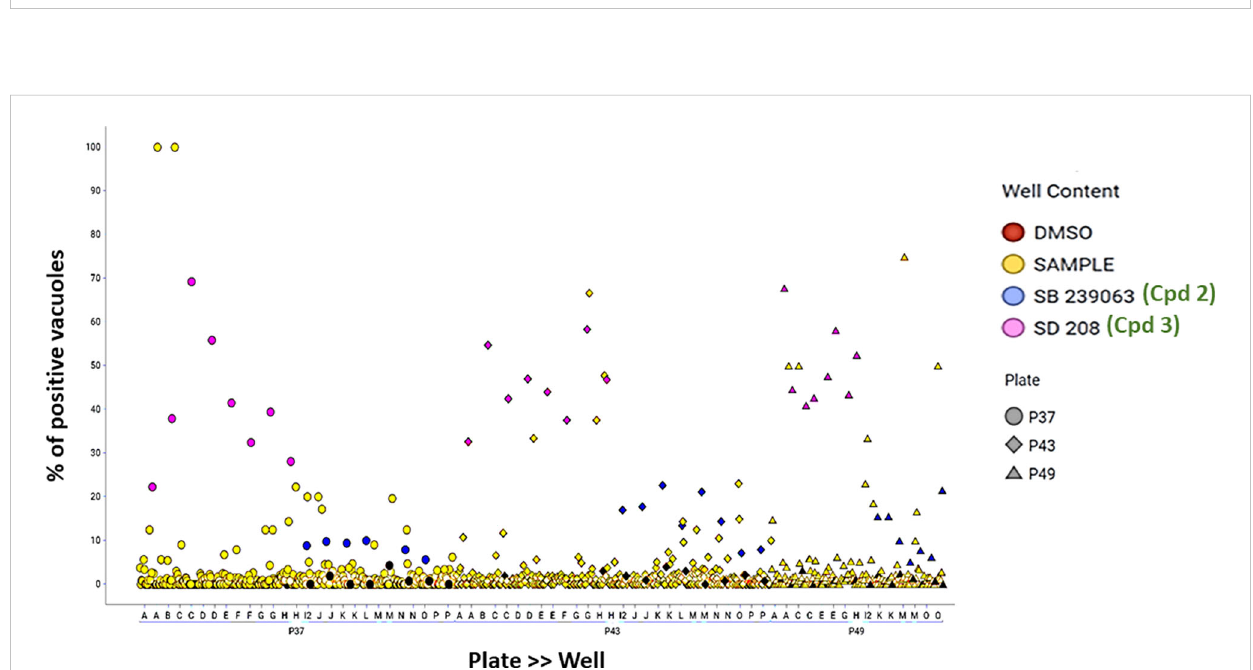
FIGURE 6 Data dot plot for each of the three screening plates — P37 (circles), P43 (diamonds) and P49 (triangles). The percentage of positive vacuoles is shown before normalization on the Y-axis. Red color corresponds to the negative control (DMSO), and blue and pink denote the positive controls — SB 239063 (Cpd2) and SB 208 (Cpd3) — in each plate, while yellow color is used for the tested compounds and black for non-infected